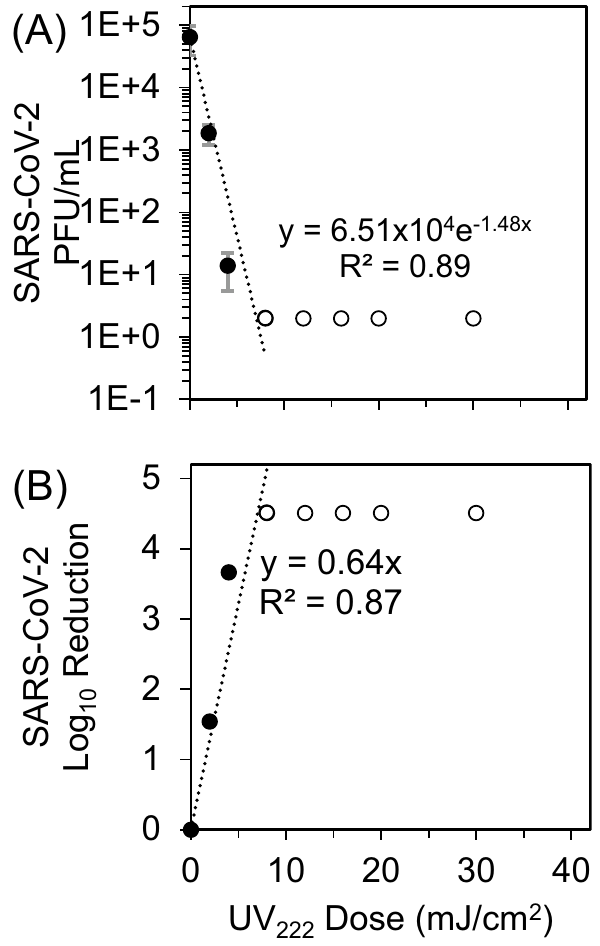
Figure 2. ( A ) SARS-CoV-2 titers measured by plaque assay 3 days after sample exposure to each UV 222 dose (dark circles) were fit with an exponential model starting at the mean initial (0 mJ/cm 2 ) viral titer of 6.51 × 10 4 PFU/mL through responses up to and including 8 mJ/cm 2 where PFU/mL first dropped below the assay detection limit (DL) of 2 PFU/mL (hollow circles). Error bars represent standard deviation of at least two technical replicates. ( B ) SARS-CoV-2 log 10 reductions (LR) of viral titers after exposure to each UV 222 dose (dark circles) were calculated from ( A ) and fit with a linear model forced through the origin at 0 mJ/cm 2 through responses up to and including 8 mJ/cm 2 where LR first exceeded the DL of 4.51 logs (hollow circles). Representative plaque assay results for Experiment 2 are shown in Supplementary Fig.